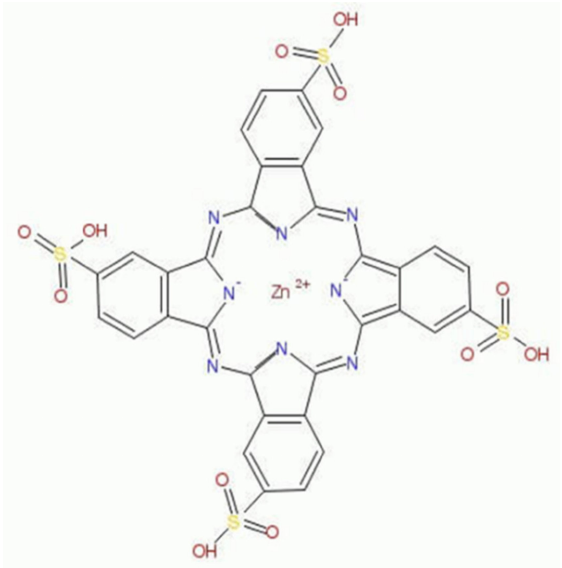
Figure 1. Structure of zinc sulfothiolphthalocyanine (ZnPcS 4 )